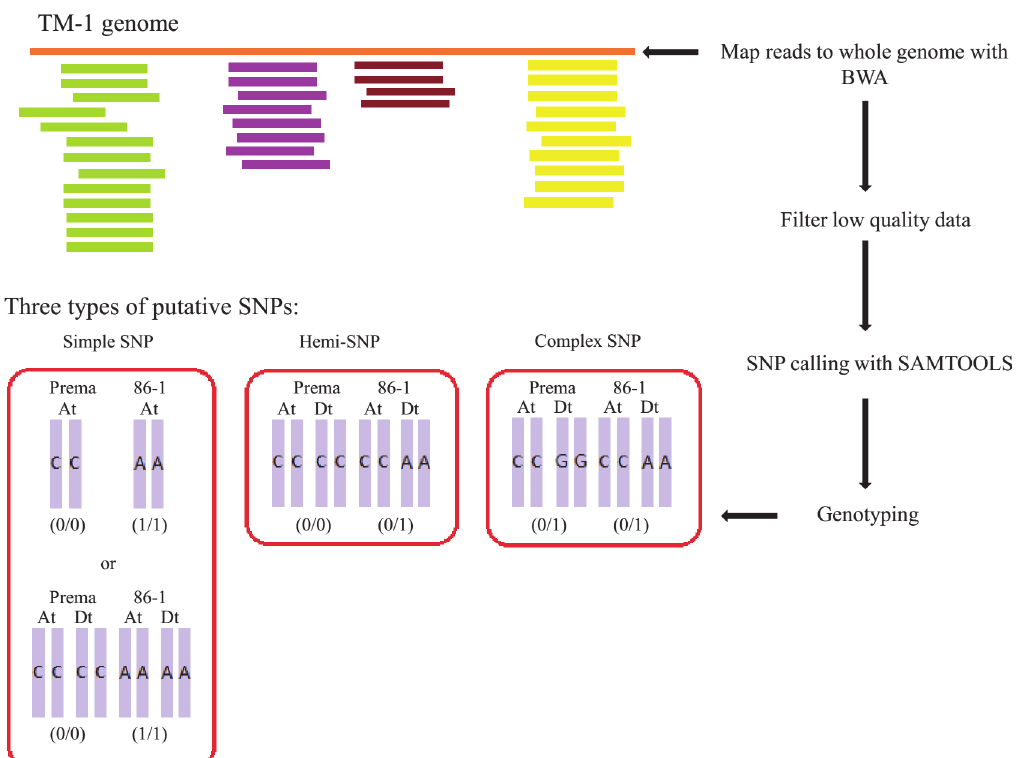
Fig 1. SNP development and genotyping pipeline for cotton RAD markers. Raw reads were aligned to the TM-1 reference genome with BWA software. After filtering and SNP calling, the putative SNPs were divided into three types: simple SNPs with one allele per parent, and complex SNPs which with one allele from one parent and two alleles from the other parent or SNPs with two alleles from both parents.